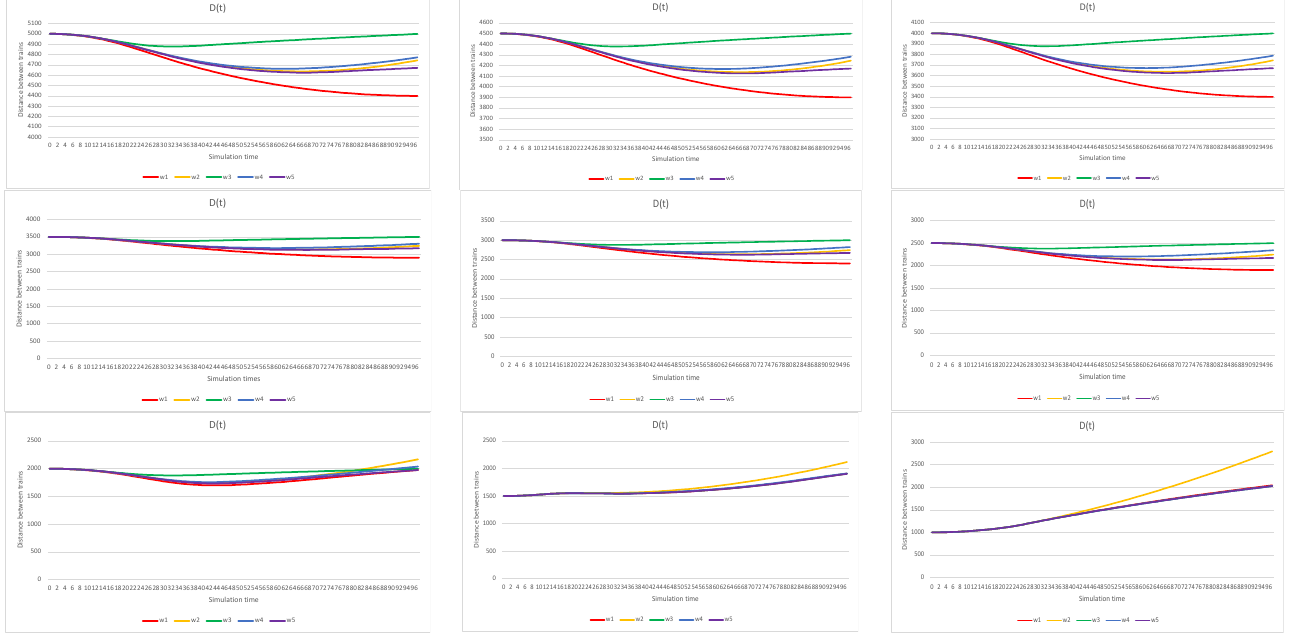
Figure 13. Summary of distance curves D(t) for D 0 = 5000, 4500, 4000, 3500, 3000, 2500, 2000, 1500, 1000 (m) in simulation for context 1.